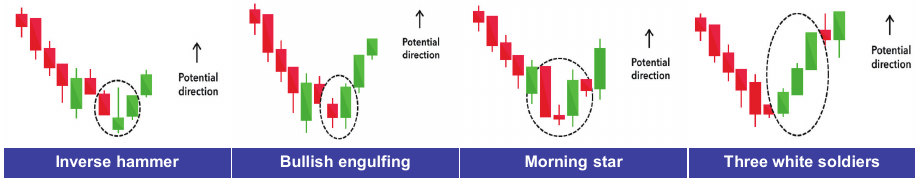
Figure 3. Four examples of bullish candlestick